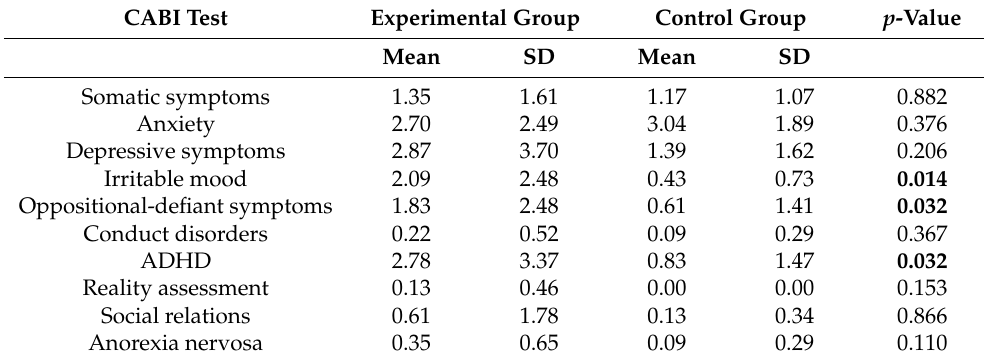
Table 3. Age-and sex-adjusted analyses of CABI domains between EG and CG. Table 2. Comparison of CABI domains between EG and CG. CABI Test